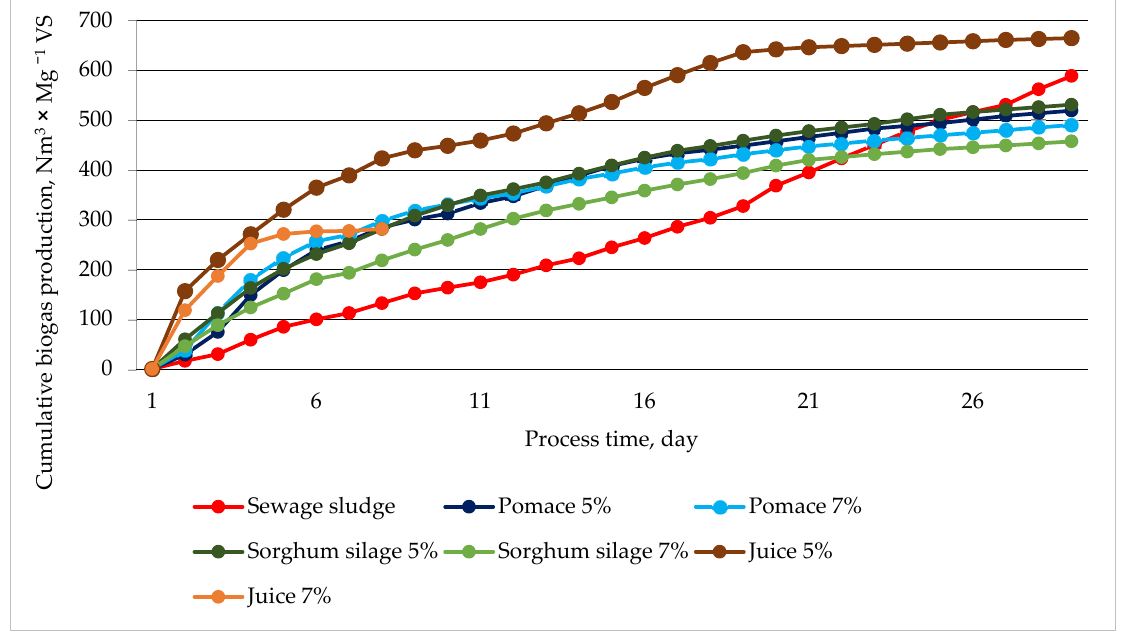
Figure 3. Average percentage methane production from sewage sludge and substrates from sor- ghum. Moreover, the amount of methane as Nm 3 ∙ Mg − 1 VS was determined (Figure 4). Most of the methane was obtained from juice (5%) (358.3 Nm 3 ∙ Mg − 1 VS), and, for sorghum pom- ace and silage, the amount of methane was at a similar level: 213.4 and 216.7 Nm 3 ∙ Mg − 1 VS, accordingly (Table 3). Other authors [37] reported a methane yield of 400 Nm 3 ∙ Mg − 1 VS for sorghum. In other studies, the methane production from maize sorghum reached values from 232 to 387 Nm 3 ∙ Mg − 1 VS [38], which is similar to the results obtained in this research. Maize silage is the most popular substrate used in agricultural biogas plants. According to research by Herrmann et al. [39], methane production from maize ranged from 319 to 376 Nm 3 ∙ Mg − 1 VS.